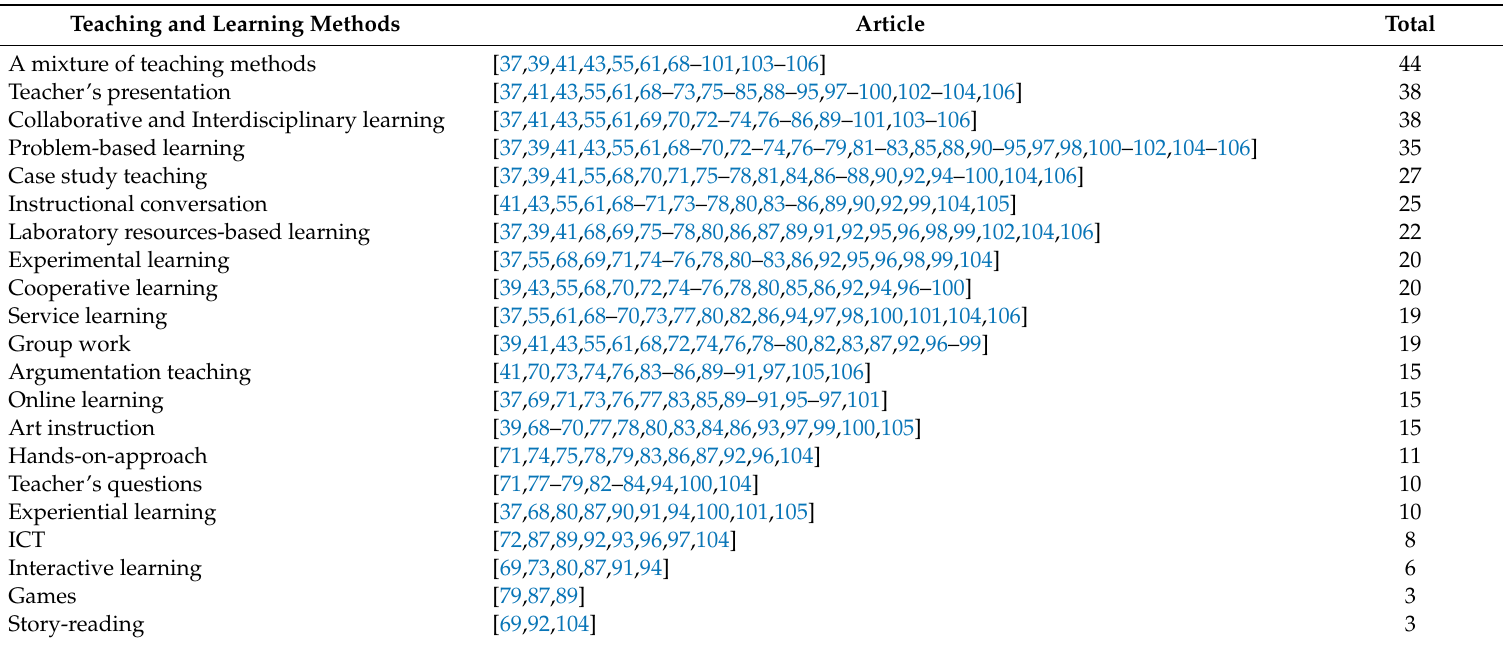
Table 3. The teaching and learning methods mentioned in the 45 articles